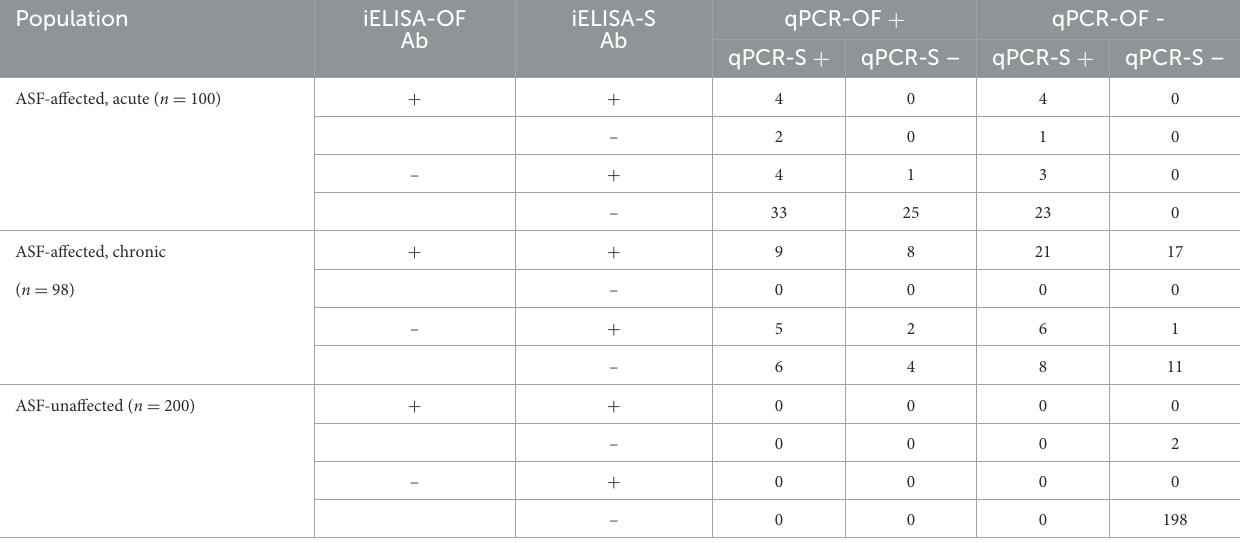
swine fever (CSF) virus. Few farms also vaccinated for Porcine Reproductive and Respiratory Syndrome (PRRS).